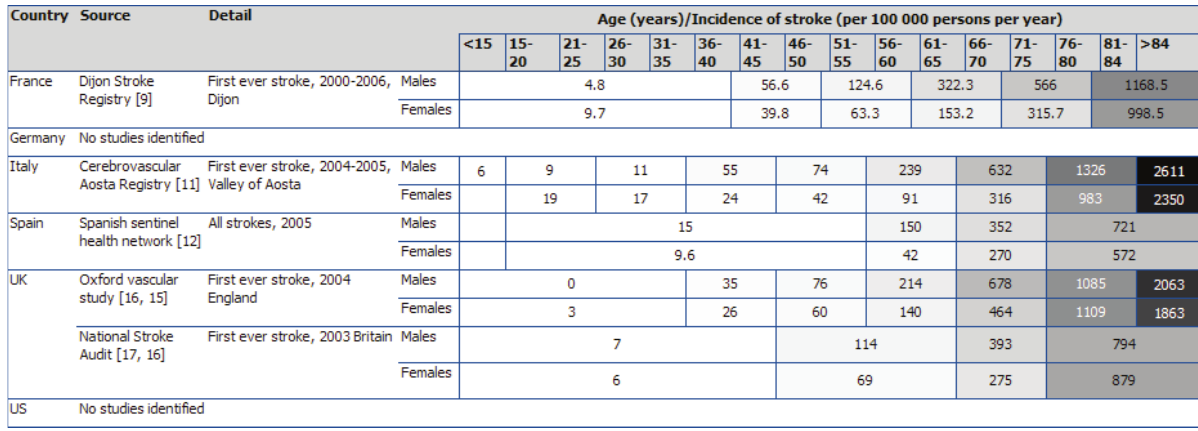
Figure 1: Studies reporting the relationship between the incidence of stroke and age. Incidence reported as cases per 100 000 per year. Darker shading indicates higher incidence. BHF: British Heart Foundation, UK: United Kingdom. Sources: [9; 11; 12; 15; 16; 17].